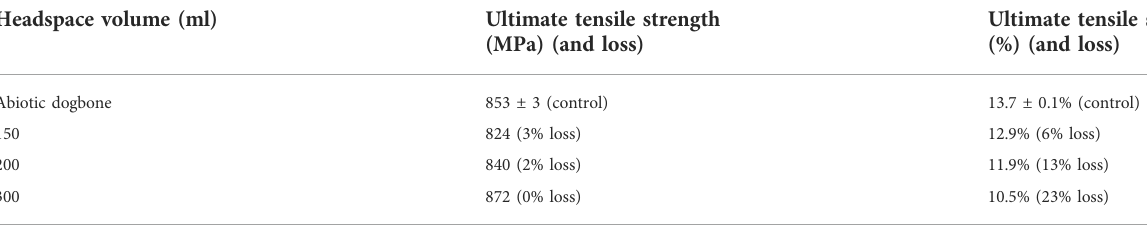
TABLE 5 Ultimate tensile strength and ultimate tensile strain data from Figure 11. Headspace volume